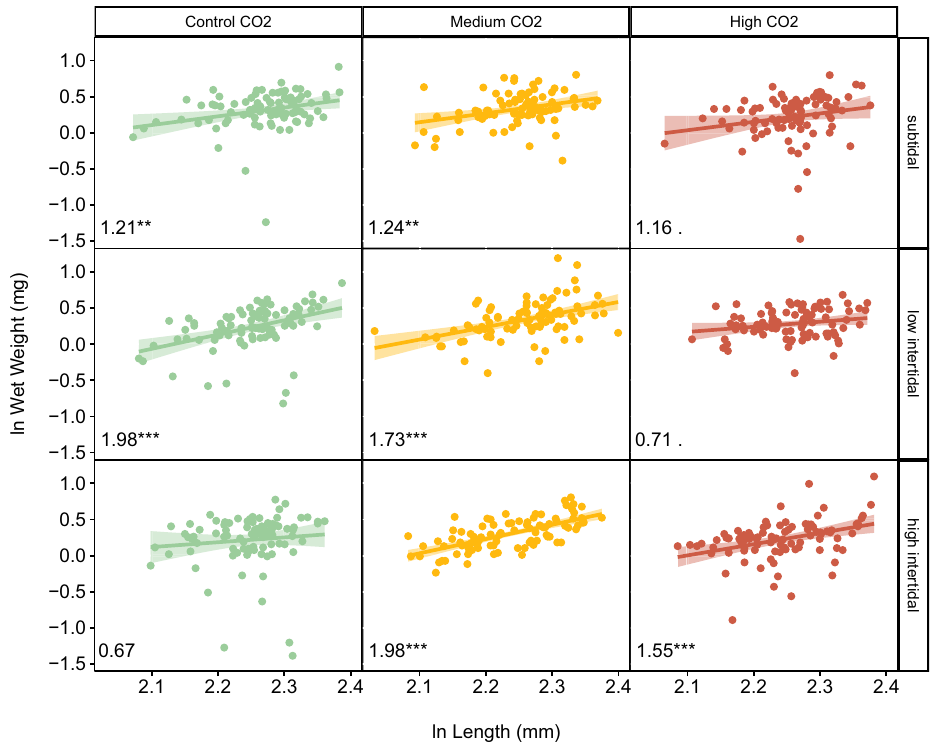
Figure 5. The weight to length relationship is positively impacted by air exposure with increasing CO 2 level. Relationship between (natural logarithm of) wet weight and length of larvae for each of the CO 2 treatments (Control = 400 µatm; Medium = 1600 µatm; High = 3000 µatm CO 2 ) and tidal regimes (subtidal = no air exposure; low intertidal = 2 × 2 h air exposure day −1 ; high intertidal = 5 + 9 h air exposure day −1 ) showing all individual larvae measured with smoothed linear regression and 95% CI. Numbers at the bottom of each panel show the slope of the relationship, with the significance of the fitted regression indicated by stars (Signif. codes: 0.001 > ***; 0.01 > **; 0.05 > *; 0.1